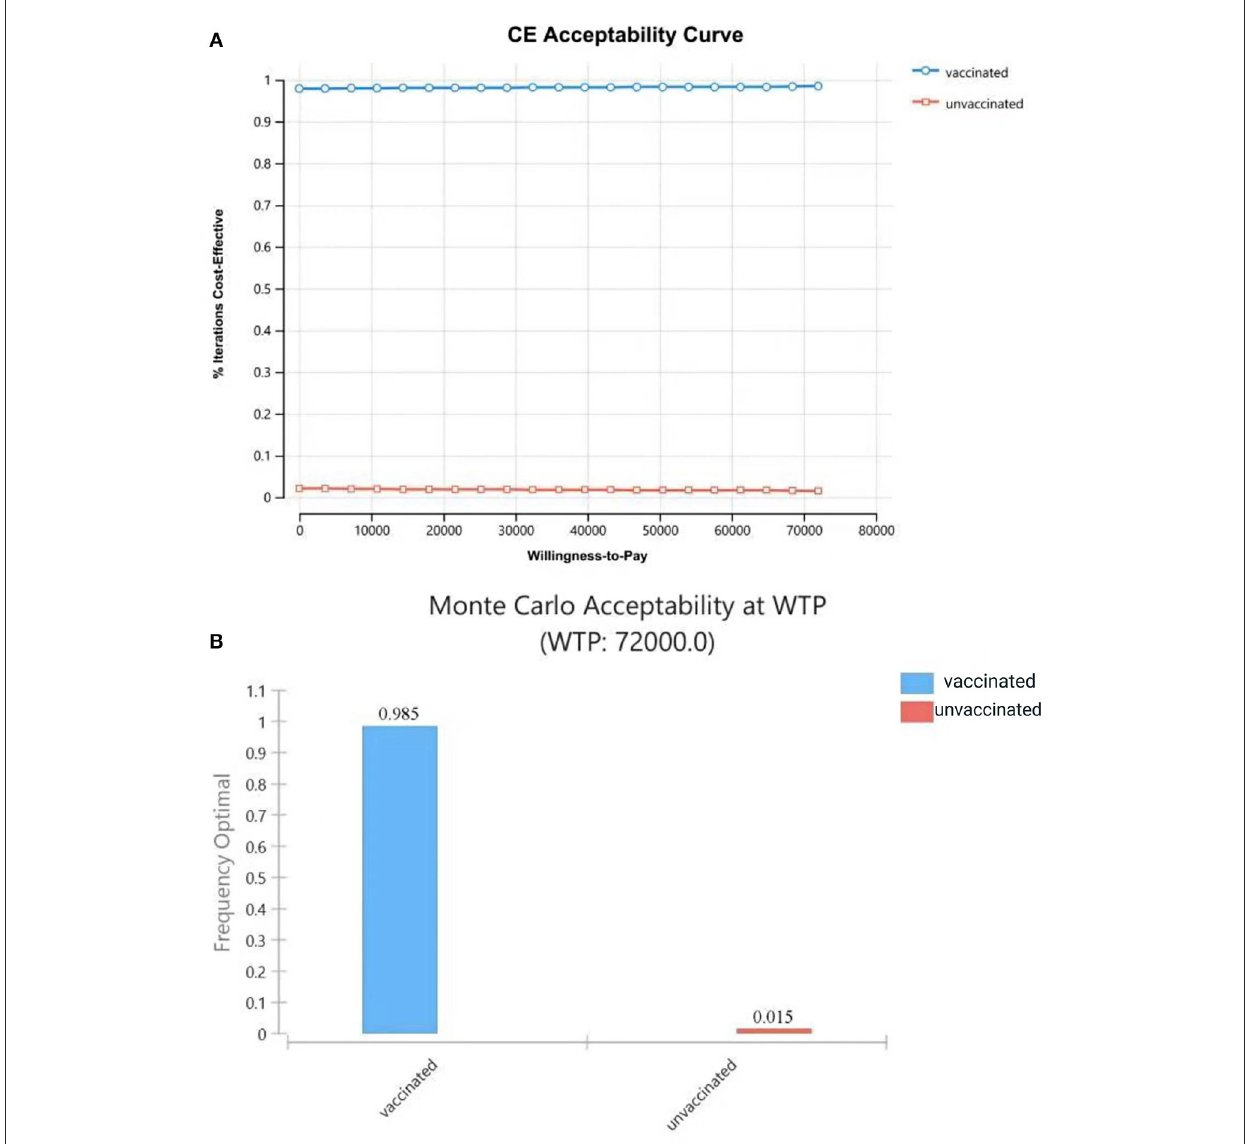
FIGURE8 Cost-effectiveness acceptability curve (A) shows the probabilities of being cost-effective for “vaccinated” and “unvaccinated”, when the WTP ranges from 0 to 72,000CNY; (B) shows probabilities of being cost-effective when WTP is 72,000 CNY.